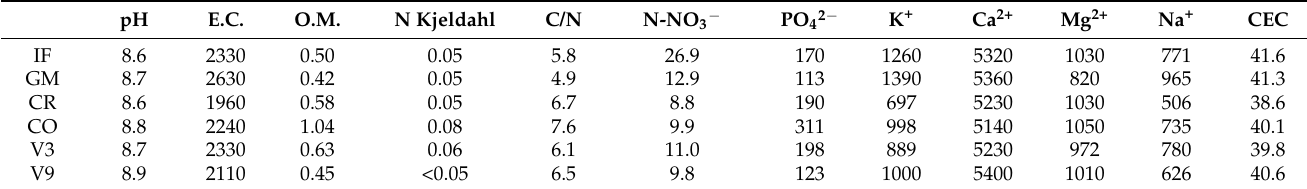
Table 6. Effects on soil chemical proprieties in tomato crops fertilised with inorganic fertilisers (IF), goat manure (GM), crop residue (CR), compost (CO), vermicompost at 3 (V3) and 9 kg m − 1 (V9), during the tomato crop cycle